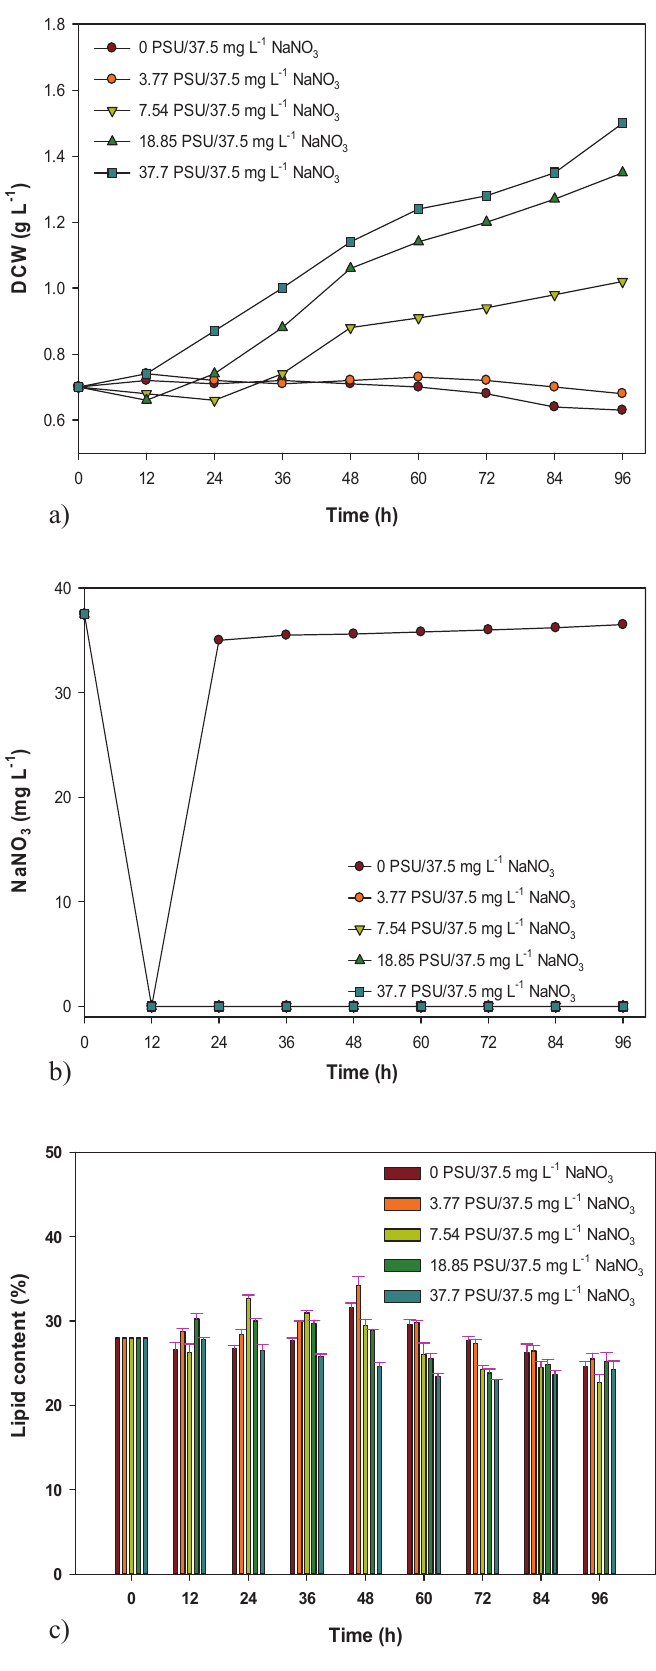
Fig. 3 – Effect of salinity variation and fixed nitrogen (37.5 mg L –1 ) on (a) dry cell weight, (b) nitrogen